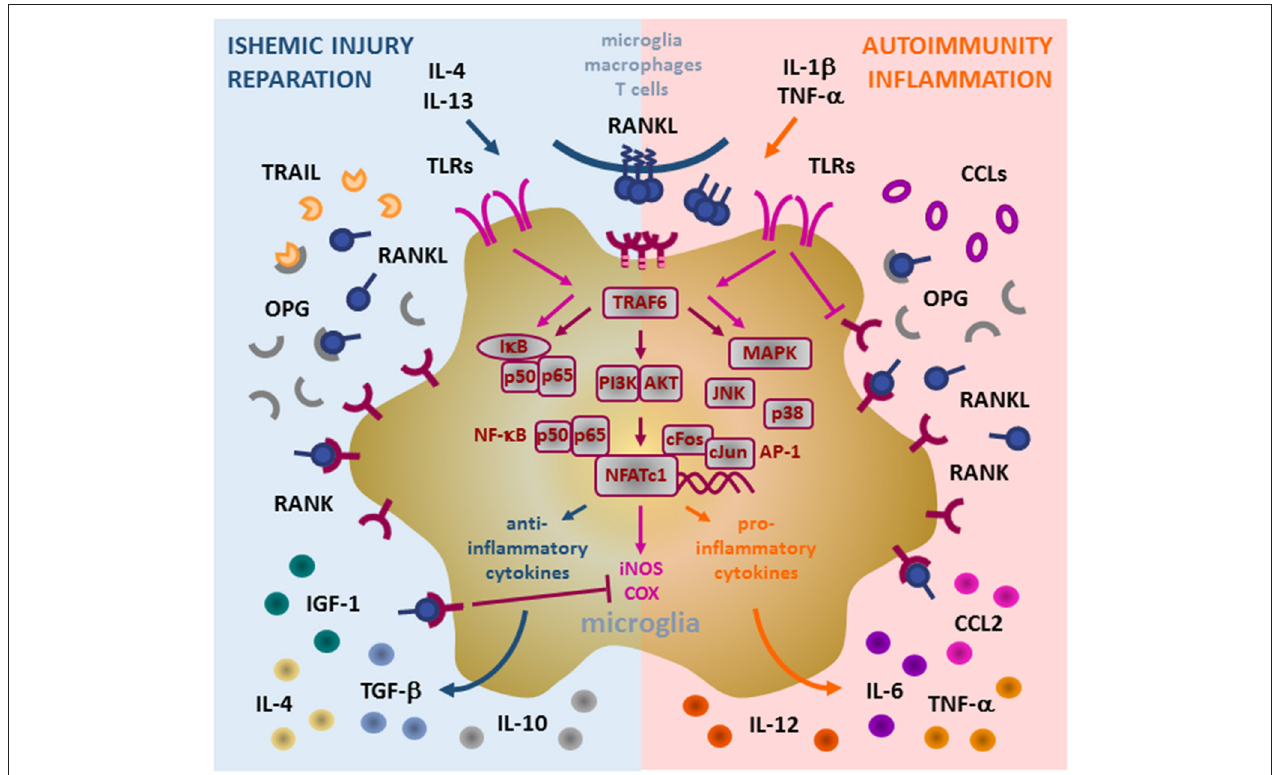
FIGURE 2 | Role of RANK/RANKL/OPG (RRO) axis in microglia. Binding of membrane or soluble RANKL induces trimerization of RANK expressed on the microglia and initiates signal transduction. RANK lacks the intrinsic enzymatic activity in its intracellular domain and transduces a signal by recruiting adaptor molecules from the TRAF family of proteins, mainly TRAF6 (via three TRAF6-binding sites in its C-terminal cytoplasmic tail). Upon formation of the RANK/TRAF6 complex, multiple signaling pathways are activated, including NF- κ B (activation of p65:p50 subunits/I κ B complex), PI3K/AKT, and MAPK (including p38 and JNK). These signaling cascades potently induce transcription factors NFATc1 and AP-1 (cFos and cJun) to initiate transcription of target genes. In pathological conditions, microglia acquire different context-dependent functions. Under ischemic conditions, induced by anti-inflammatory IL-4 and IL-13 cytokines, microglia may exhibit neuroprotective action by production of immunosuppressive and reparative cytokines and growth factors (IL-4, IL-10, TGF- β , and IGF-1). Under such response, induced RANKL production and overexpression of RANK contribute to transcription of anti-inflammatory mediators and suppress iNOS and COX induced by TLR (TLR3/TLR4) signaling, whereas upregulation of OPG blocks ligation of TRAIL and protects microglia from apoptosis. During inflammatory and autoimmune processes, pro-inflammatory IL-1beta and TNF-alpha cytokines drive microglia to support inflammatory reaction. Enhanced RANKL/RANK signaling in this context may promote up-regulation of pro-inflammatory cytokines and chemokines (including TNF- α , IL-6, CCL2, IL-1 β ), which in turn attract additional inflammatory and immune cells, induce Th1 polarization of infiltrating T cells by IL-12 and thus, neural tissue damage. TLR signaling interfere with RANK signaling in microglia, namely TLR4 suppress RANK expression but auto-amplify TLR3-initiated cascades (NK- κ B and MAPK), thus perpetuating the microglia inflammatory response. However, the precise mechanisms of the signaling interplay between RANK and TLRs are still to be fully revealed. RANK, receptor activator of nuclear factor- κ B; RANKL, RANK ligand; OPG, osteoprotegerin; TRAF, TNF receptor-associated factor; IL, interleukin; TNF, tumor necrosis factor; TGF, transforming growth factor; IGF, insulin-like growth factor; CCL, CC-chemokine ligand; TRAIL, TNF-related apoptosis-inducing ligand; TLR, Toll-like receptor; NF- κ B, nuclear factor- κ B; I κ B, inhibitor of NF- κ B; PI3K/AKT, phosphatidylinositol 3-kinase/protein kinase B; MAPK, mitogen-activated protein kinase; AP-1, activator protein 1; NFATc1, nuclear factor of activated T cells, cytoplasmic